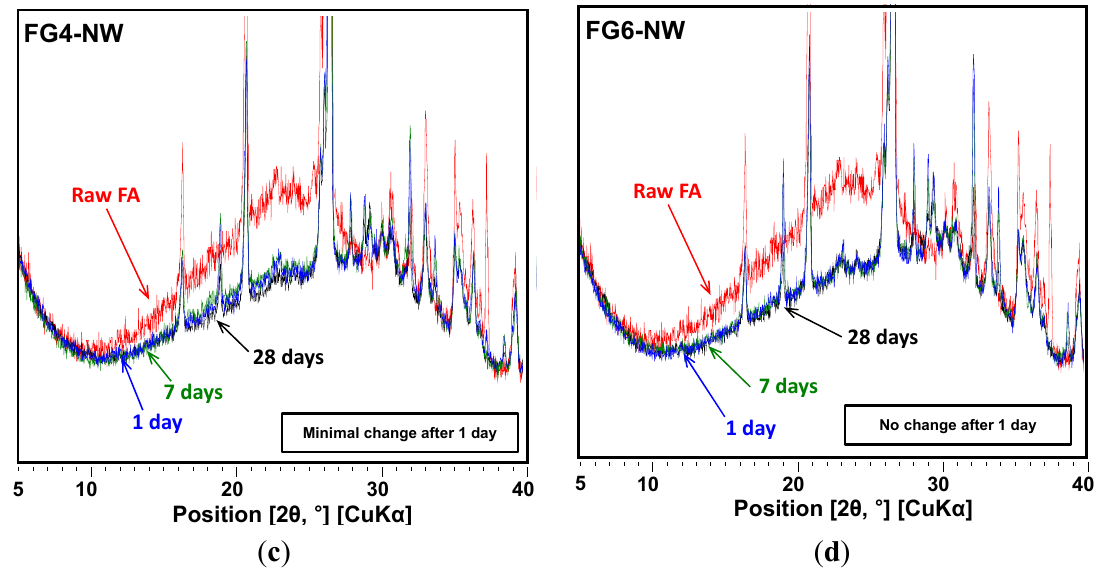
Figure 5. Progressive changes of overlapped XRD patterns for the amorphous phase ( i.e. , 10° to 32°) as curing progresses. ( a ) F-NW sample; ( b ) FG2-NW sample; ( c ) FG4-NW sample; ( d ) FG6-NW